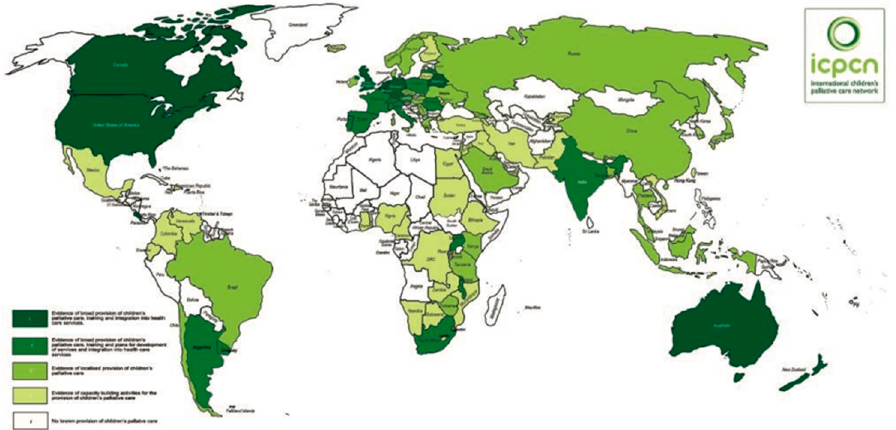
Figure 1. Situation in 2019 of provision of CPC around the world, reprinted with permission from ref. [6]. Copyright 2019 ICPCN. The dark green colour indicates broad availability of CPC in several places, but there is still room for improvement.